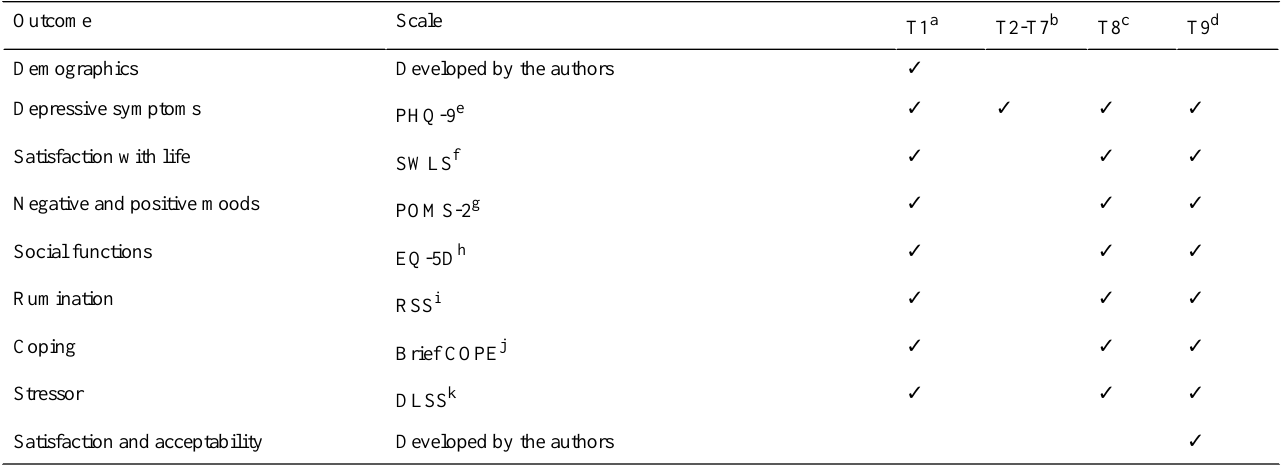
Table 1. Overview of